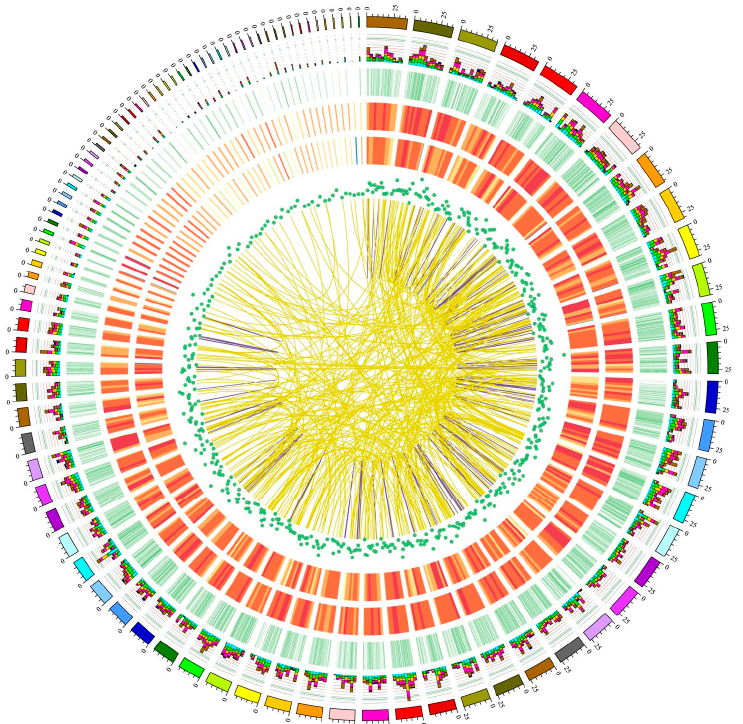
Figure 6. CIRCOS visualization of different data of Ryukin at the genome-wide level. From the outer to the inner are goldfish chromosomes of the reference genome, stacked histogram of alternative splicing loci (with light blue, green, yellow, purple, red, brown, and navy blue represent RI, A3, A5, SE, MX, AF, and AL, respectively), alternative polyadenylation loci, density distribution of novel